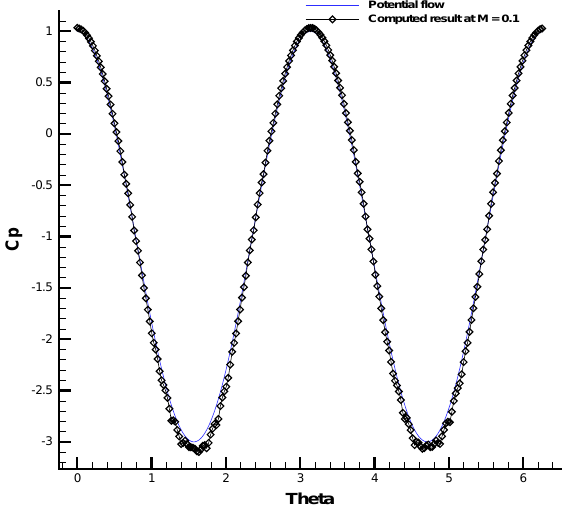
Figure 5. Comparison between potential flow and computational pressure coefficients for acoustic scattering off of a